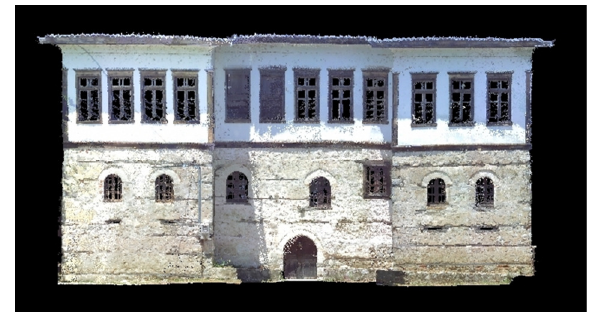
Figure 11. Skoutaris Mansion main